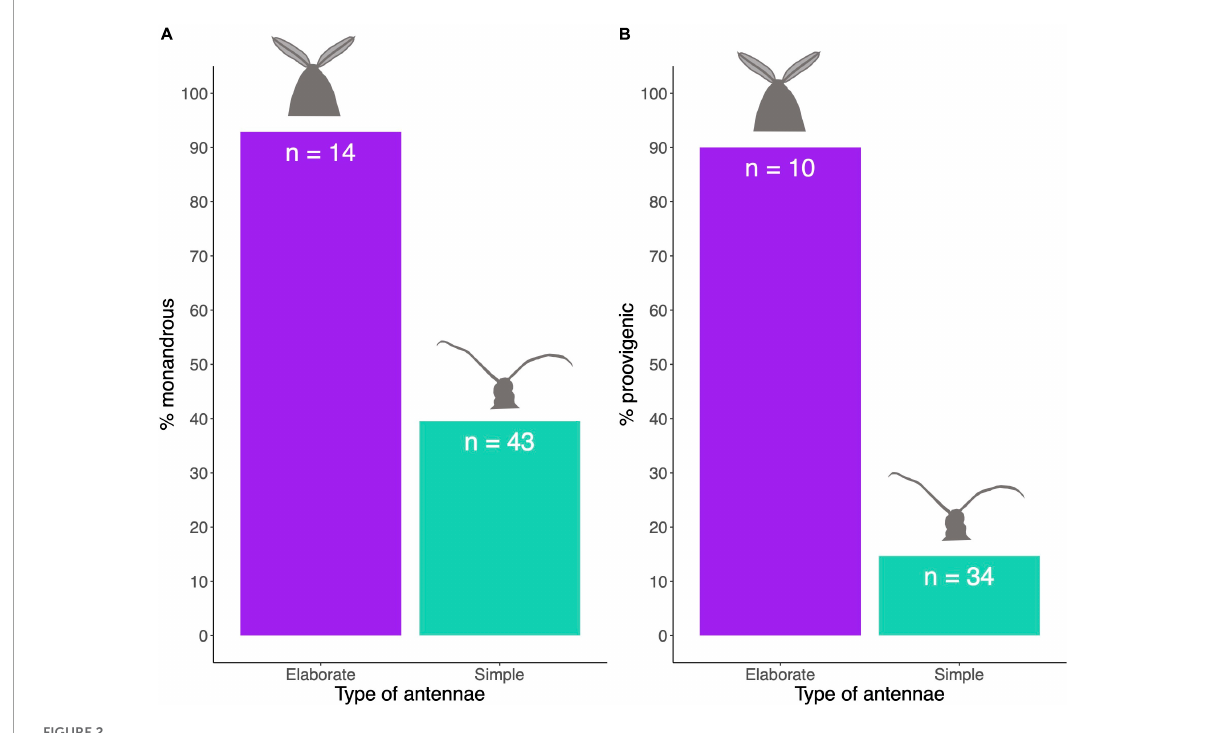
FIGURE2 (A,B) Percentage of species with particular traits relative to the type of male antennae.